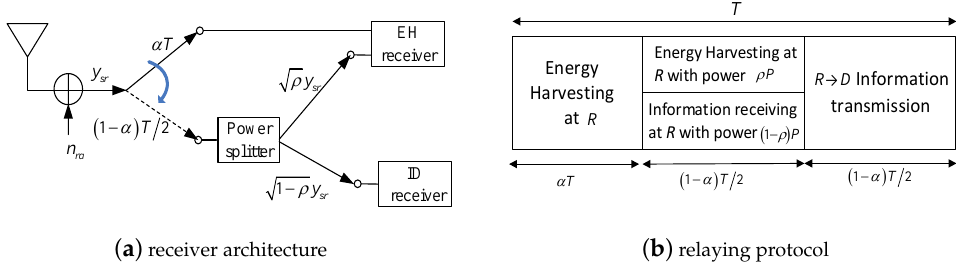
Figure 2. Hybrid relaying scheme: ( a ) receiver architecture; ( b ) relaying